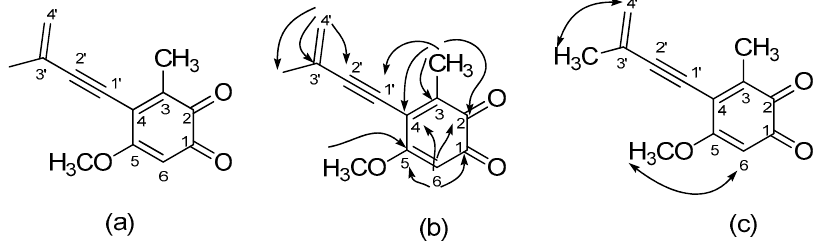
Figure 3. Structure of benzocamphorin G ( 3 ) ( a ) and its key HMBC ( b ) and NOESY ( c ) correlations.